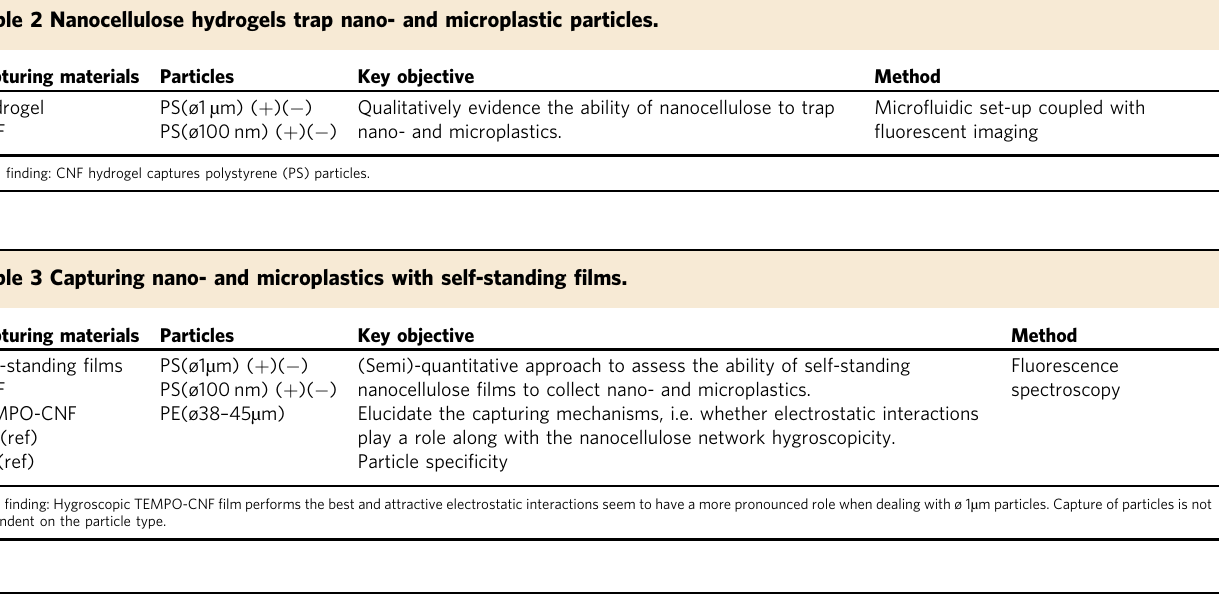
Table 4 The role of interfacial interactions — quantitative method to calculate the adsorption parameters. Capturing materials Particles